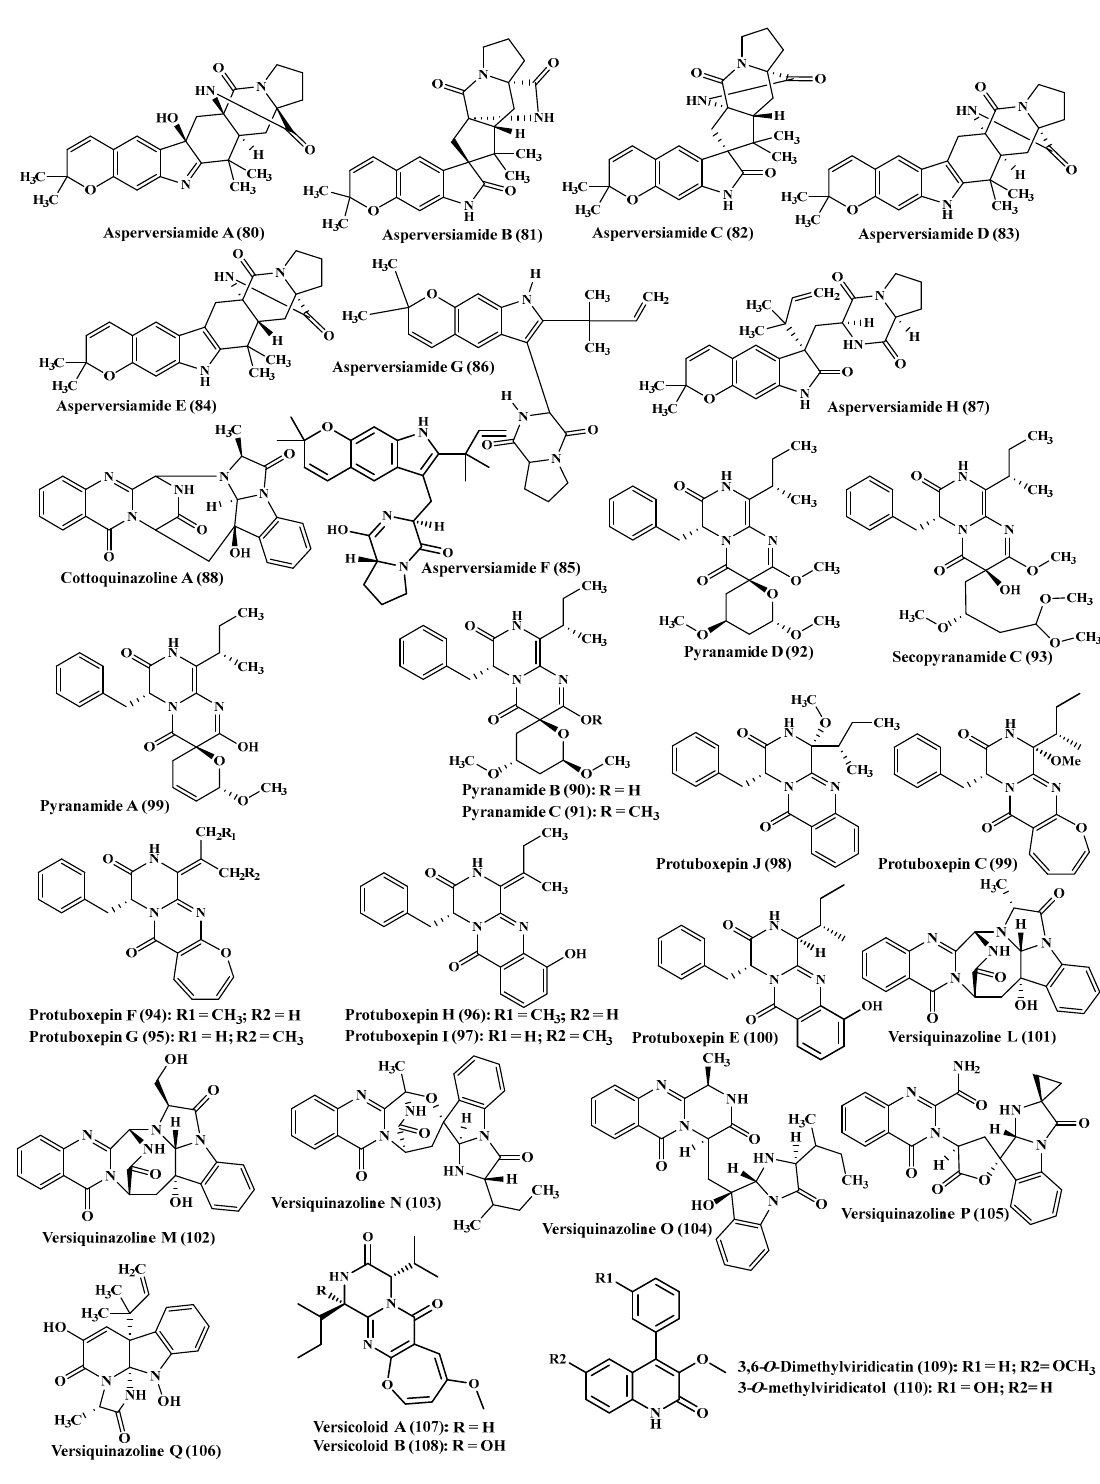
Figure 6. Alkaloids isolated from A. versicolor .